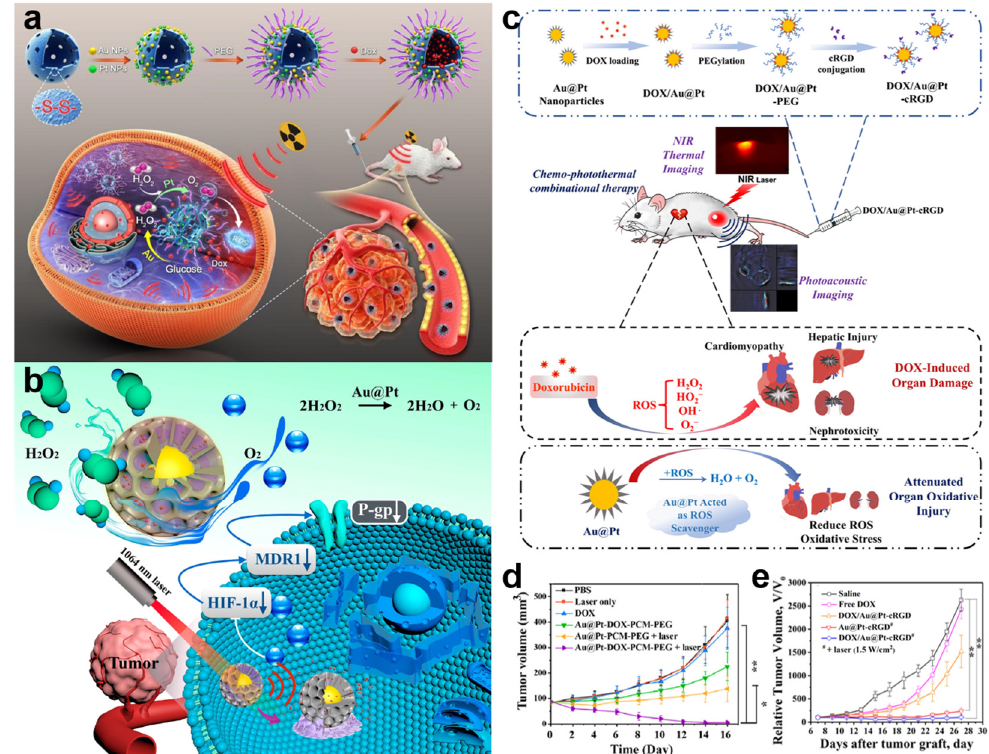
Figure 13. BMNs used in combination therapy. ( a ) Schematic diagram of the therapeutic function of HMOTP@Pt@Au@Dox. Reprinted with permission from Ref. [132]. Copyright © 2022 Elsevier B.V. ( b ) Schematic illustration of the key steps toward the synthesis of Au@Pt − DOX − PCM −